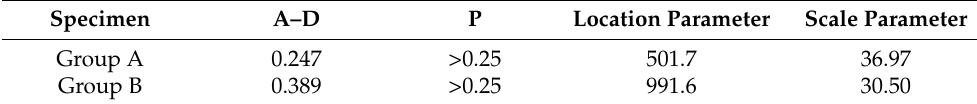
Table 8. Test of fitting degree of test piece and result of parameter estimation.